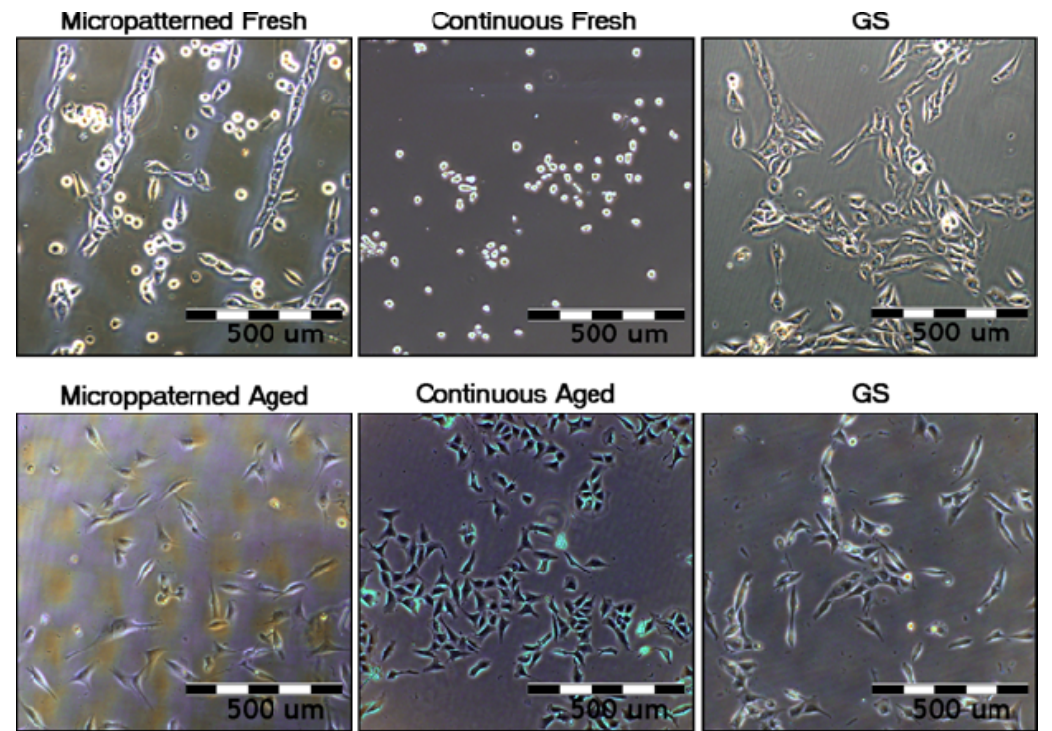
Figure 9. The morphology and preferential growth of human osteoblast-like MG-63 cells on micropatterned or continuous fresh and aged fullerene films on day 3 after seeding. GS, microscopic glass coverslips, reference